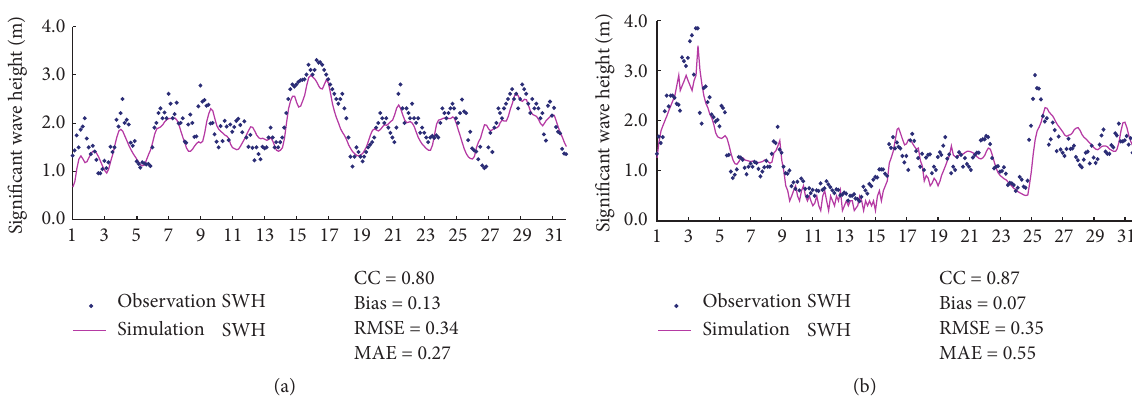
Figure 2: The simulated and observed significant wave height at Hualien for year 2011, month 1 and month 10. Unit: m.